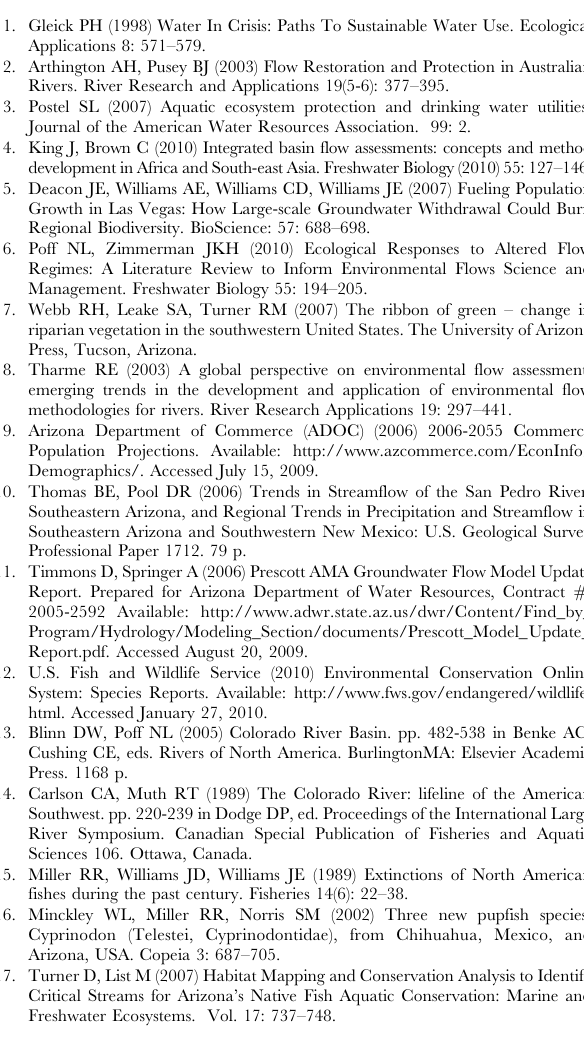
Table S2 Vulnerable aquatic, riparian and wetland species found in 18 study watersheds in Arizona. Provides taxonomic and conservation data for the imperiled species found within our study